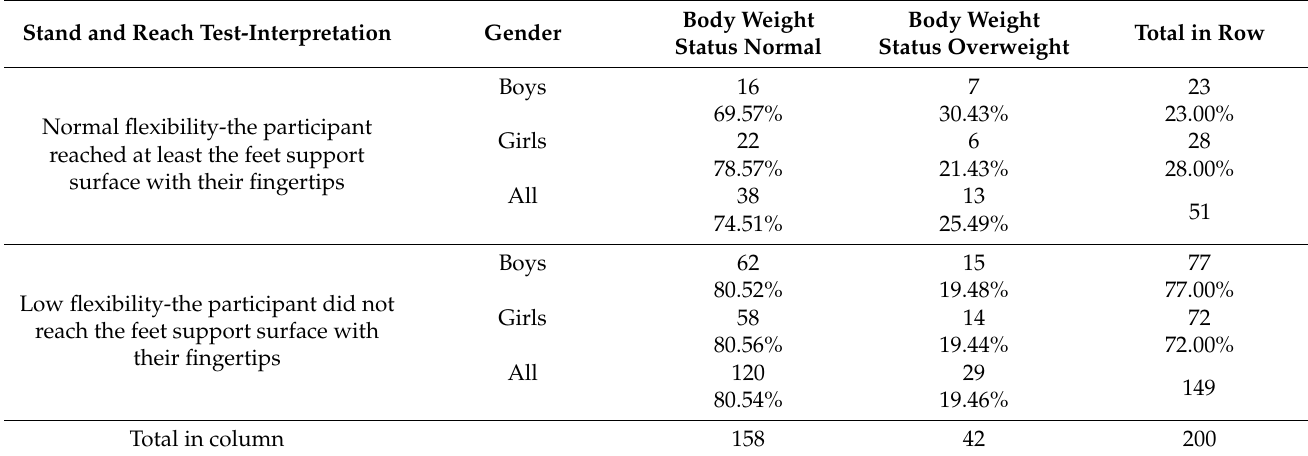
Table 4. The stand and reach test result in qualitative assessment.